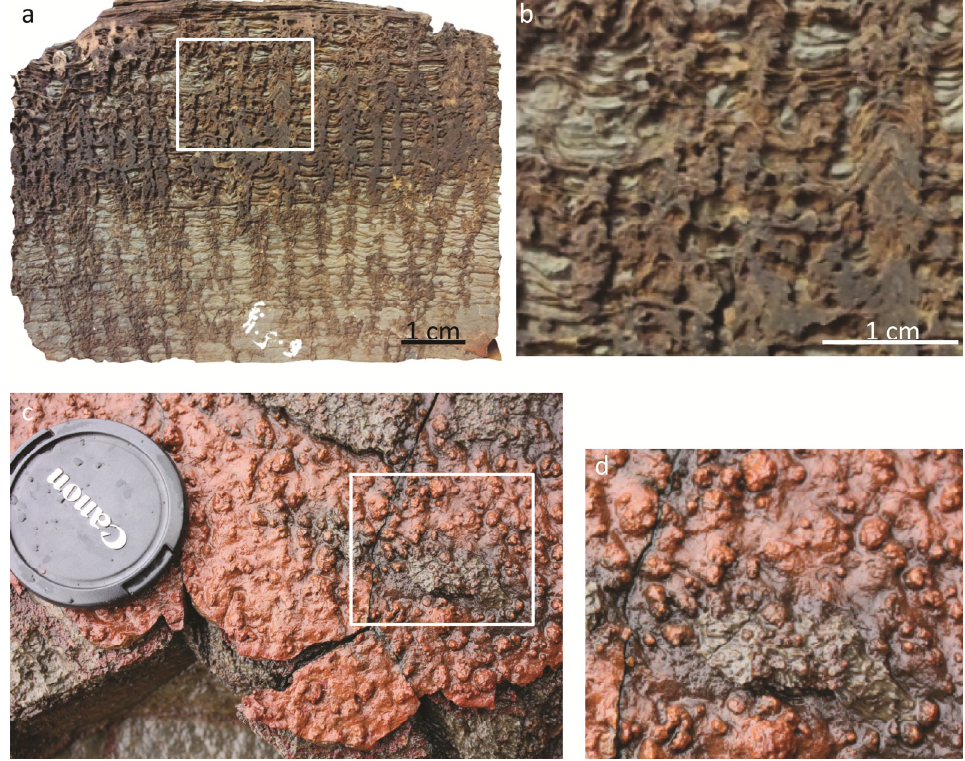
Figure 9. Morphogenetic sequence from clumps to cones preserved in an Archean conical stromatolite from the Tumbiana Formation [11]. ( a ) Vertical cross-section through cones; ( b ) Clumps in the magnified area shown by the white rectangle in ( a ); ( c ) Small, cm-scale cones and mm-scale clumps crop out on elsewhere reticulate plan-view surfaces; ( d ) Clumps in top view of the area shown by the white rectangle in ( c